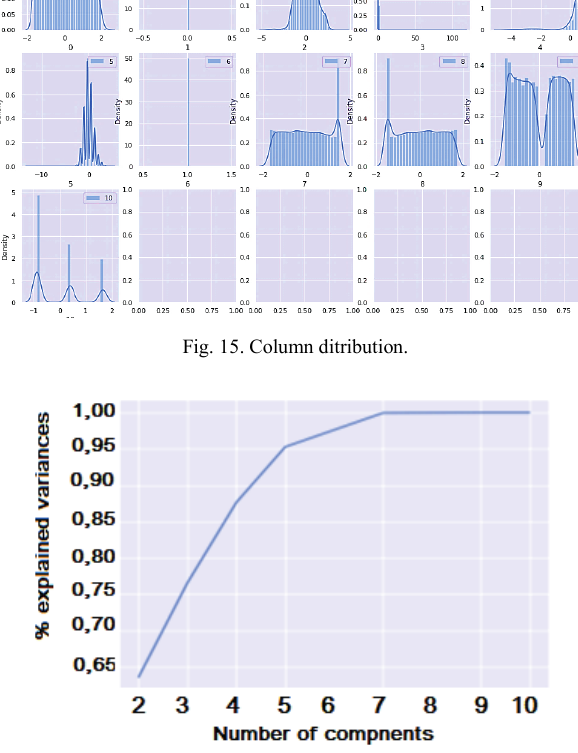
Fig. 12. OverSampling method.